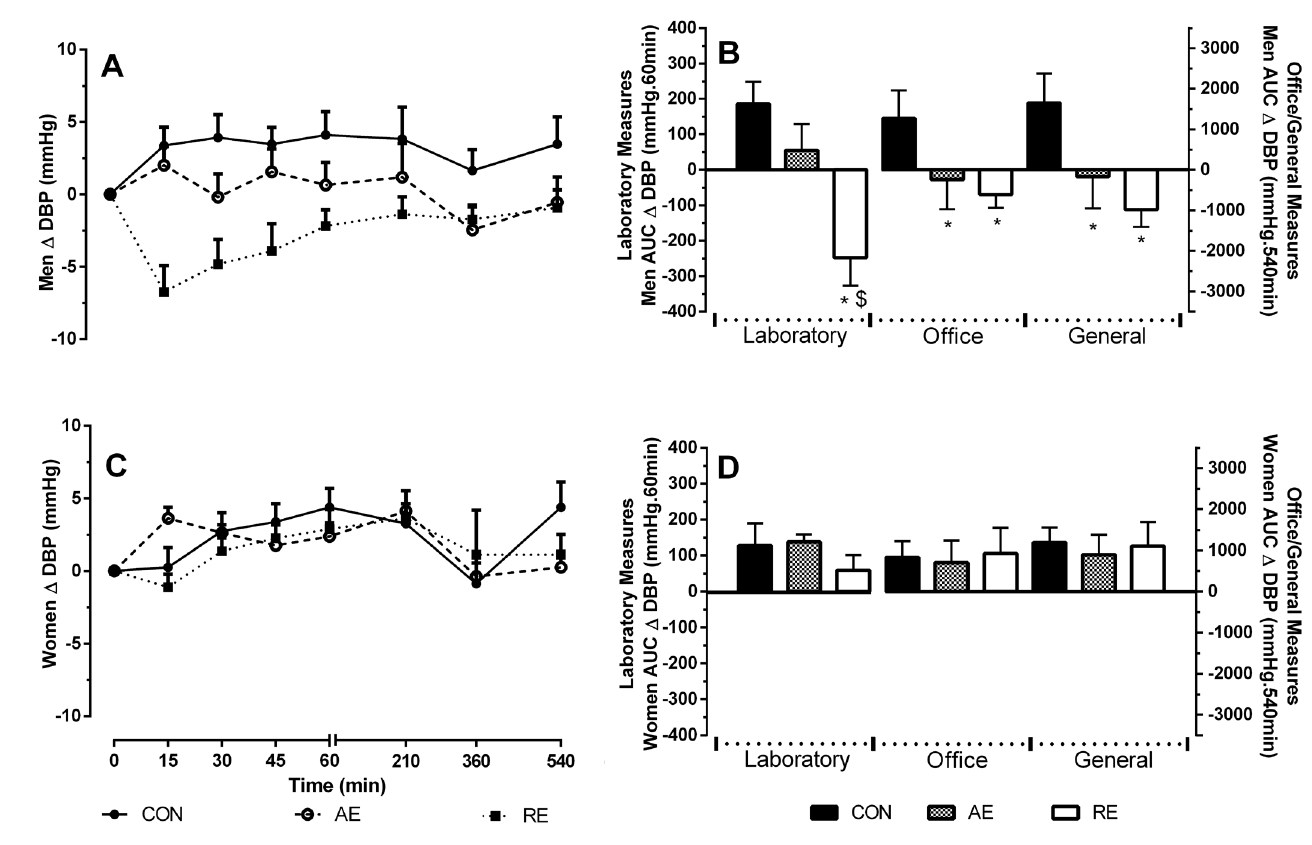
Figure 3. Delta and AUC of DBP of men and women; Time-related responses of delta DBP are present in the left side (panels A and C) and the correspondent AUC of DBP are present in the right side (panels B and D); The upper panels depict men and the bottom panels depict women results; On the right graph- Left Y axis represents 1 hour on the laboratory; Right Y axis represents 8 hours on the work place and general; AE- Aerobic session; AUC- Area Under the curve; CON- Control session; RE- Resistance session; SBP- Systolic blood pressure; * Difference with CON; $ Difference with AE.